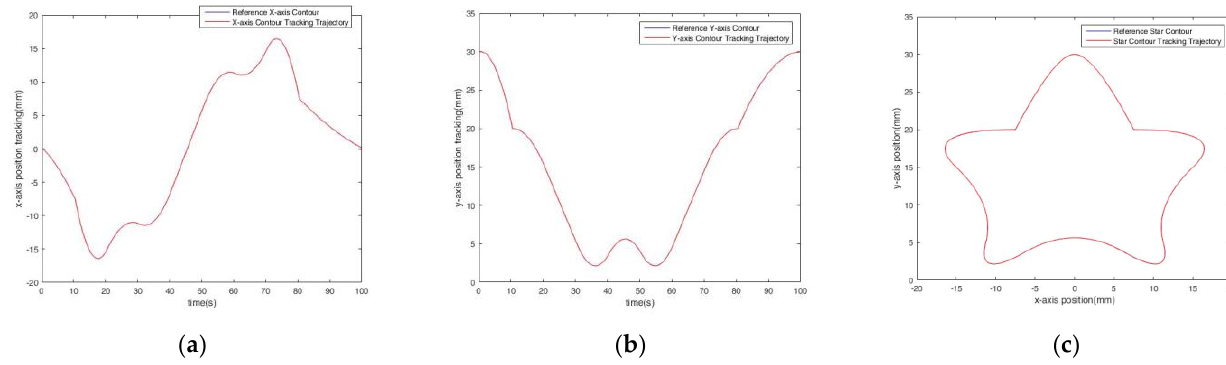
Figure 10. The path trajectory of the simulations. ( a ) The X − axis tracking response, ( b ) the Y − axis tracking response, ( c ) the star path response. Table 2. The simulated results showing contour tracking errors.